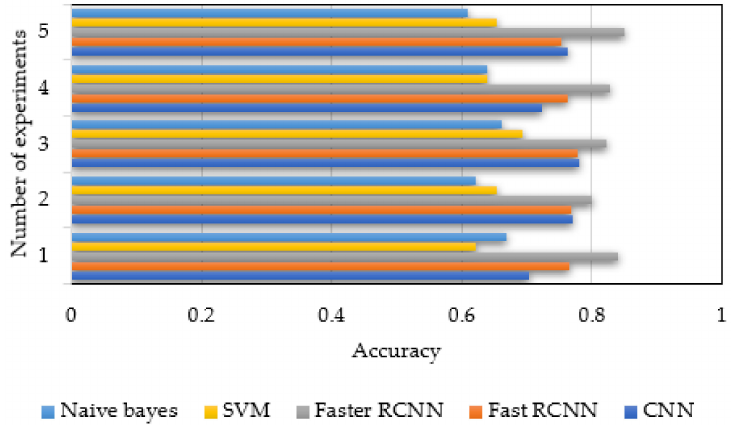
Figure 23. Accuracy of different recognition methods on the test